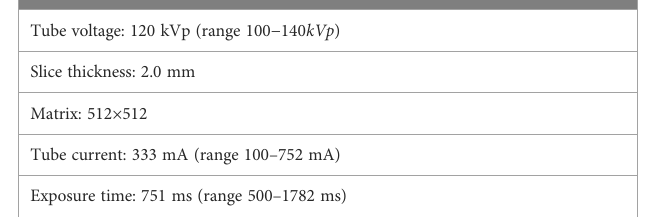
TABLE 1 Equipment parameters of this study. Manufacturers: Toshiba, GE, Phillips and